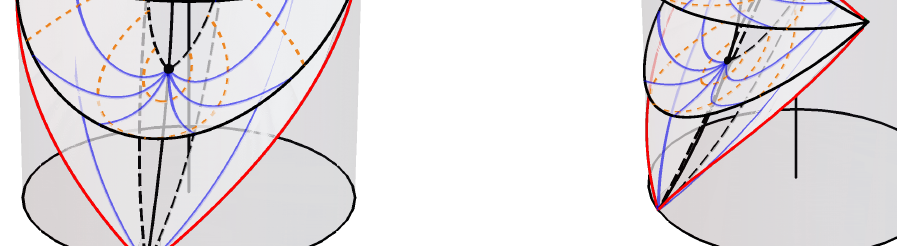
JHEP05(2022)063